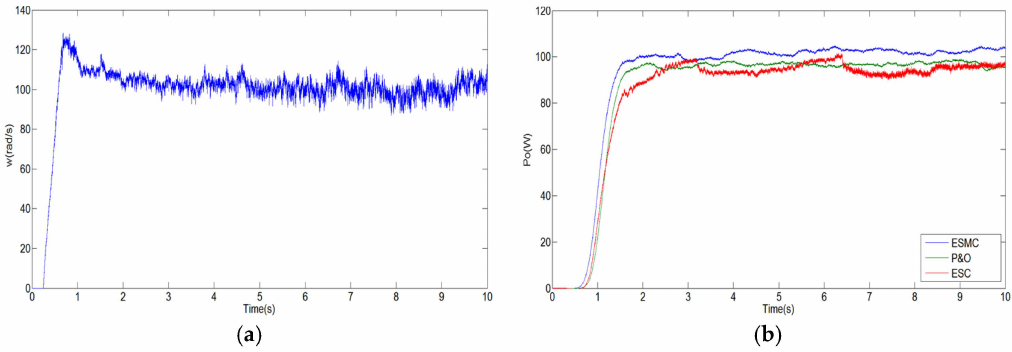
Figure 11. ( a ) Pedaling speed waveform ω (rad/s); and ( b ) comparison of the three control